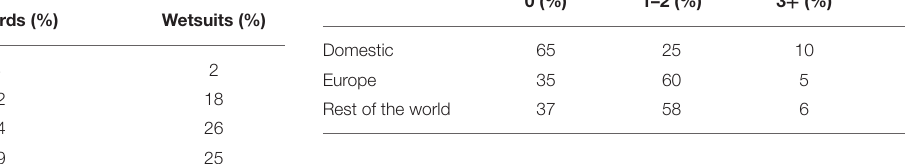
TABLE 3 | How often do you buy new surfboards and wetsuits? ( N = 240/243).